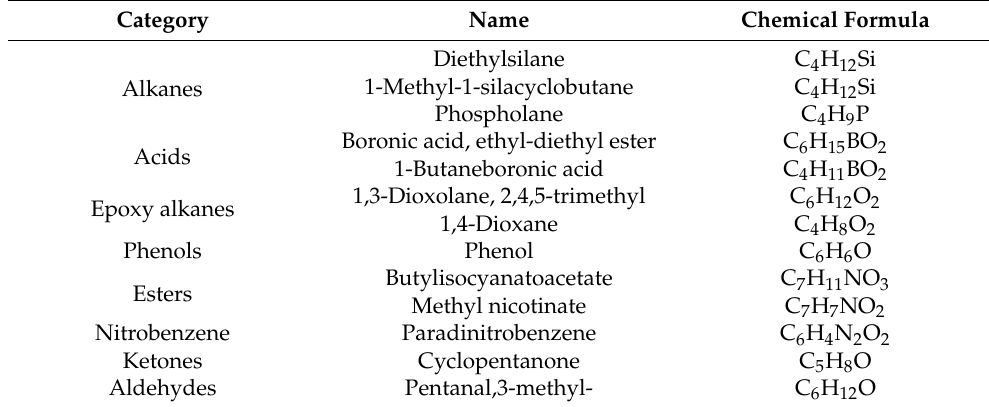
Table 2. GC/MS analysis results of resin production wastewater.